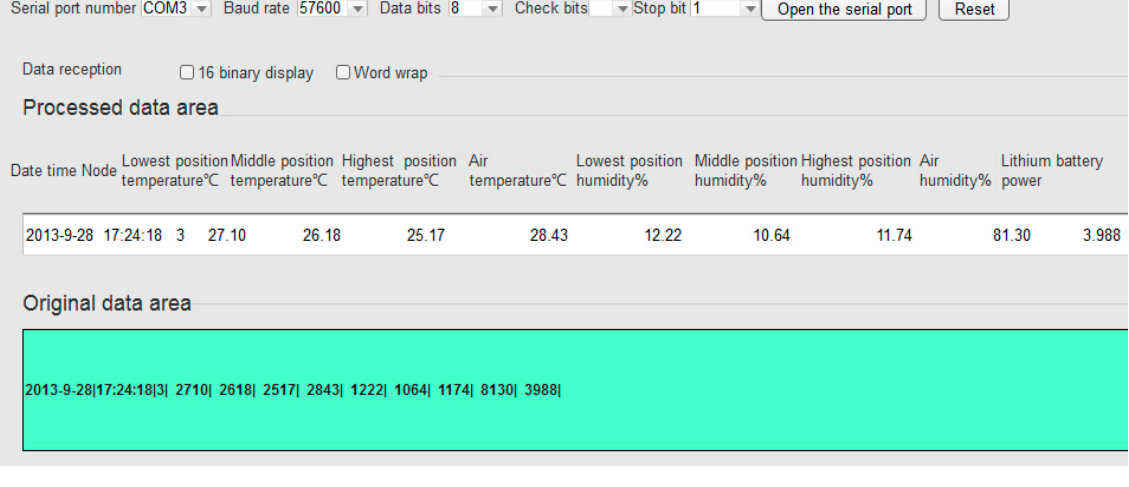
Figure 7. Remote server monitoring interface.